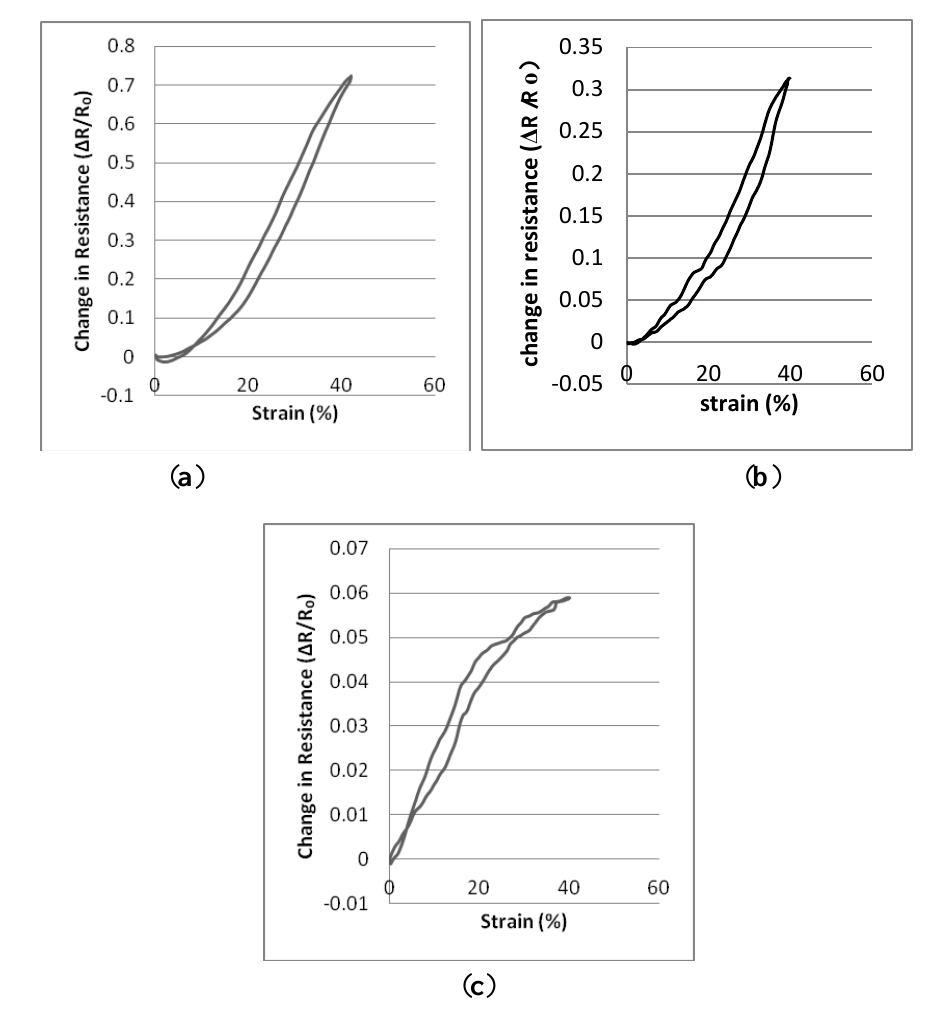
Figure 5. Relative change in resistance-strain graphs of three types of sensors. ( a ) Type 1; ( b ) Type 2; ( c ) Type